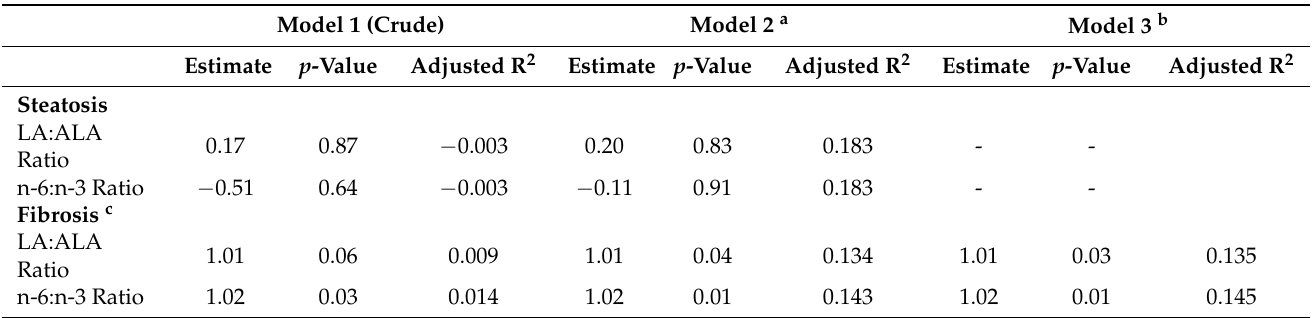
Table 3. Multiple regression results for liver steatosis and fibrosis in a Mexican-origin Hispanic sample from Southern, Arizona (N = 285).